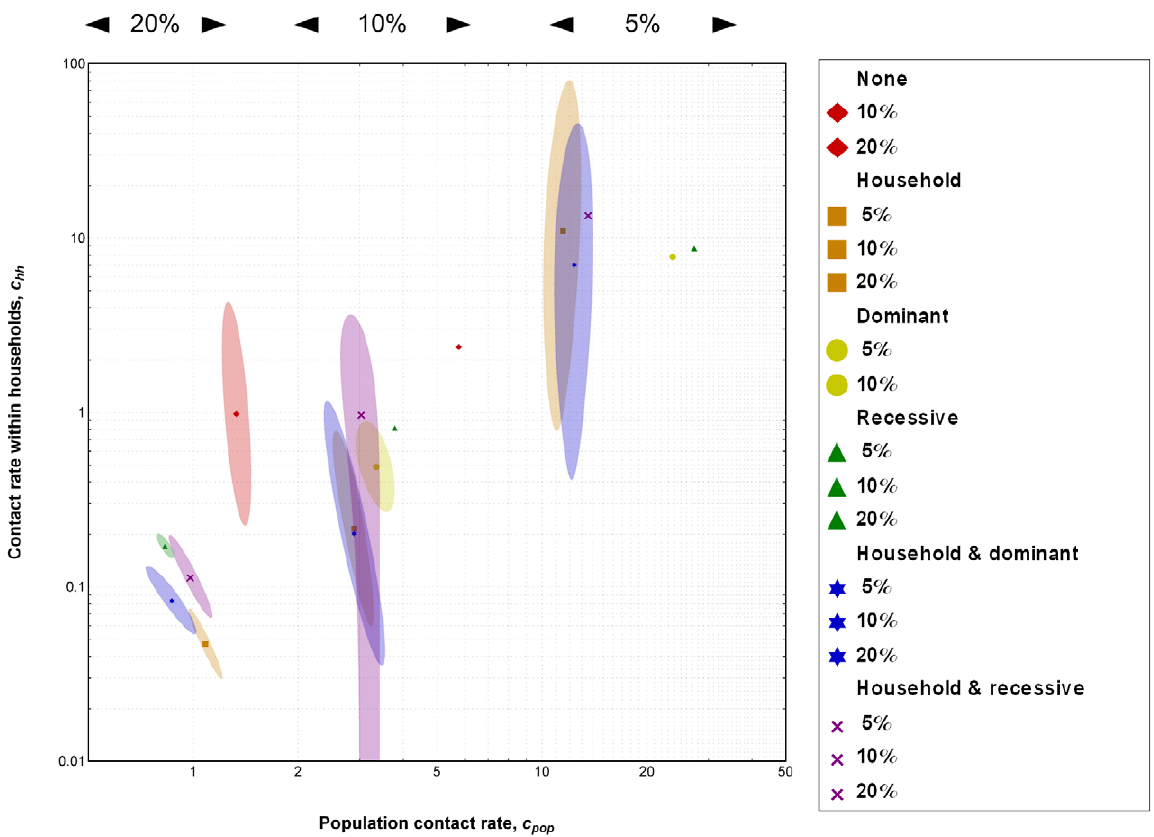
Figure 2. Best-fitting parameter combinations for the rate at which infectious contact is made in the population (contacts per year), c pop , and the contact rate within a household (contact per year), c hh , for six mechanisms of heterogeneity in leprosy susceptibility and three fractions of susceptibles. The within-household transmission is transmission on top of the population level transmission. The markers indicate the best fit for each scenario. The shaded areas in the same color indicate the area in which the fit did not differ from the overall best fitting scenario ( P . 0.01); not all mechanisms had an area with P . 0.01. The mechanisms Random (5% susceptibles) and Dominant (20% susceptibles) could not be fitted to the data, and are thus not shown.